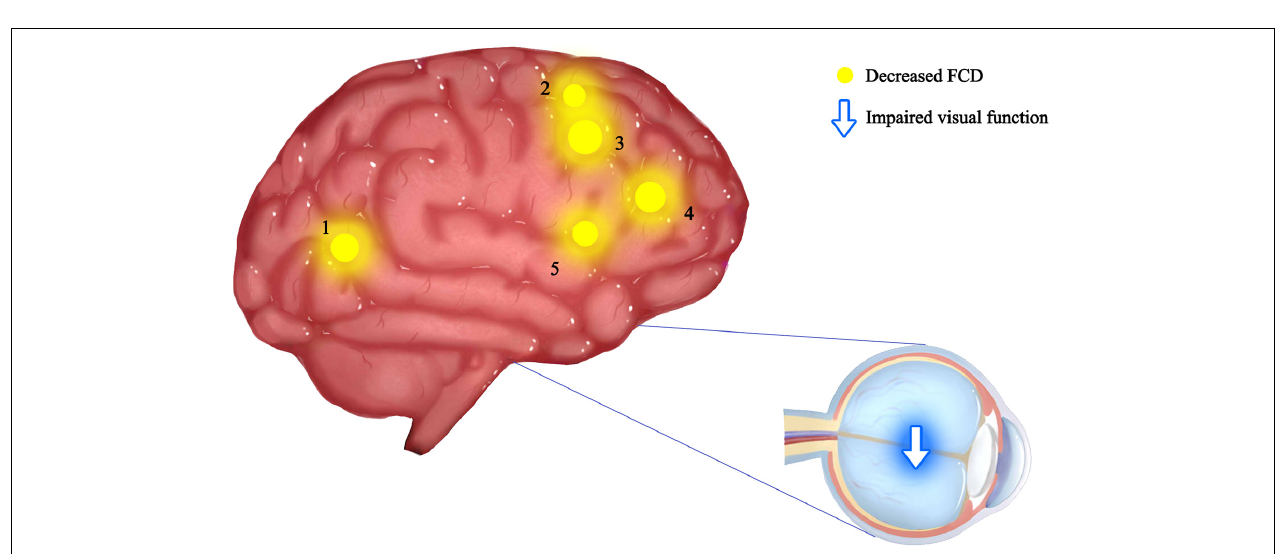
FIGURE 3 | Mean longFCD values of altered brain regions in the ON group. The spot size indicates the extent of change. The longFCD values of the following regions were reduced: 1-inferior frontal gyrus, triangular part (BA44, t = –4.14), 2-precuneus (BA7, t = –3.43), 3-anterior cingulate and paracingulate gyri (BA2, t = –3.45), 4-median cingulate and paracingulate gyri (BA24, t = –3.29), 5-median cingulate and paracingulate gyri (BA24, t = –4.01), and 6-supplementary motor area (BA6, t = –3.34). gFCD, long-range functional connectivity density; PAT, patient; HCs, healthy controls; BA, Brodmann’s area.